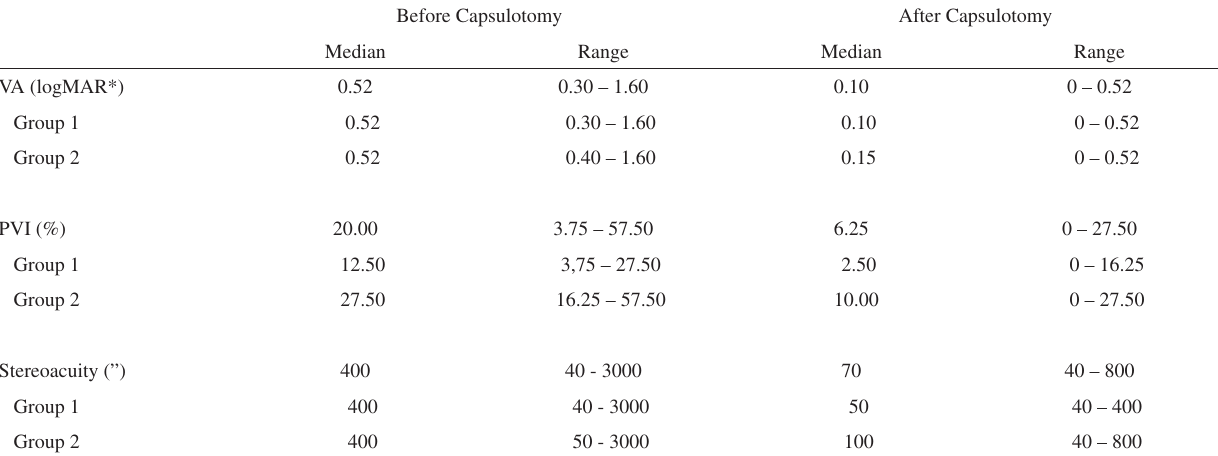
Table 1 - Visual acuity (VA), percentage of vision impairment (PVI), and stereoacuity before and after capsulotomy. Before